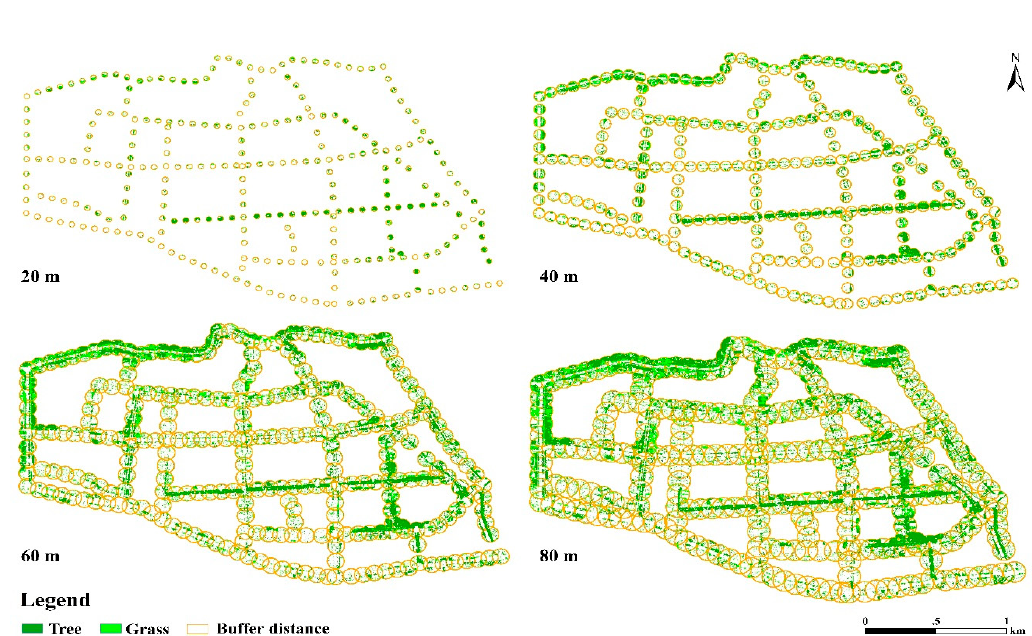
Table 2. Pearson’s correlation results of buffer distances between BGVI and green vegetation coverage. Pearson’s Correlation Coefficients Buffer Number of Street BGVI and Green Vegetation BGVI and Canopy BGVI and Grass Distance Sample Sites Coverage Coverage